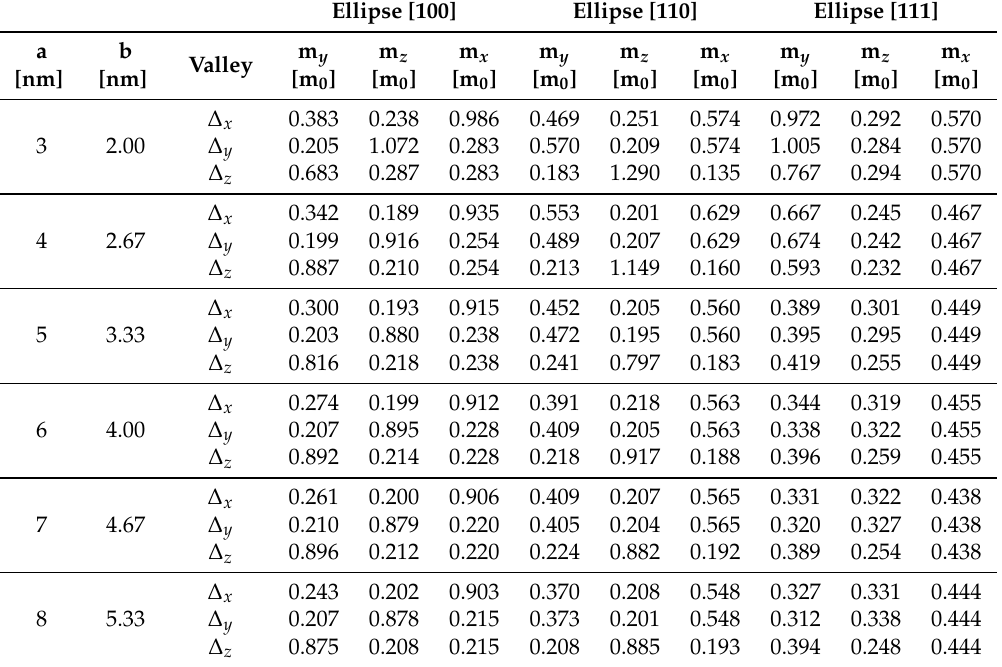
Table 3. Effective masses for elliptical nanowire having major and minor diameter as “a” and “’b”, respectively.